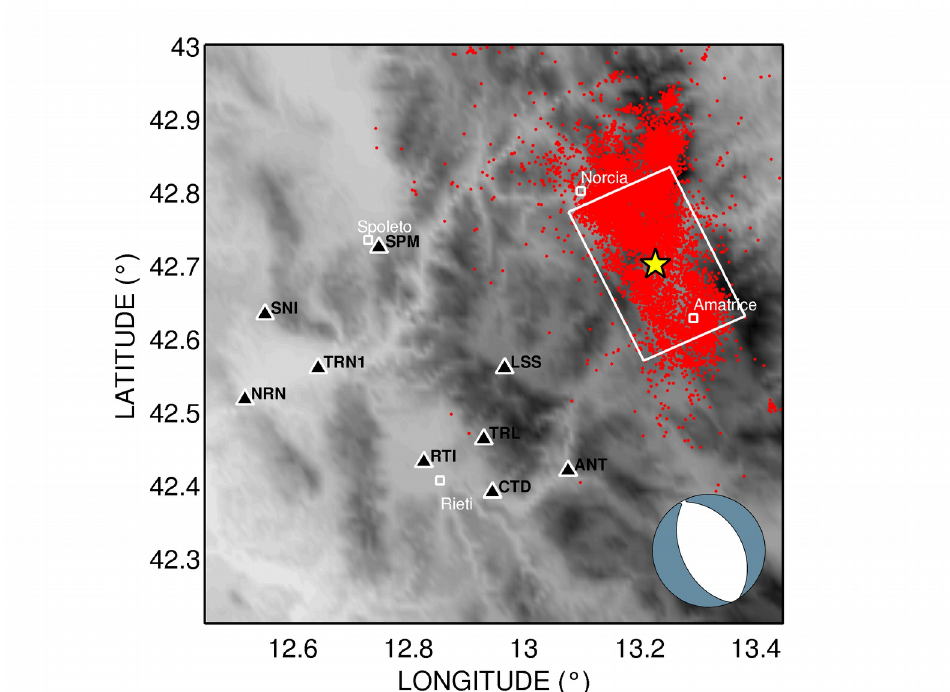
Figure 1 ­ Map of the study area, with epicentral locations updated to September 25, 2016 (red dots). Black triangles are RAN stations used for the study. The star marks the epicenter of the mainshock, and the white line is the projection of the fault to the surface. The beach ball indicates the focal solution as reported by the TDMT catalog